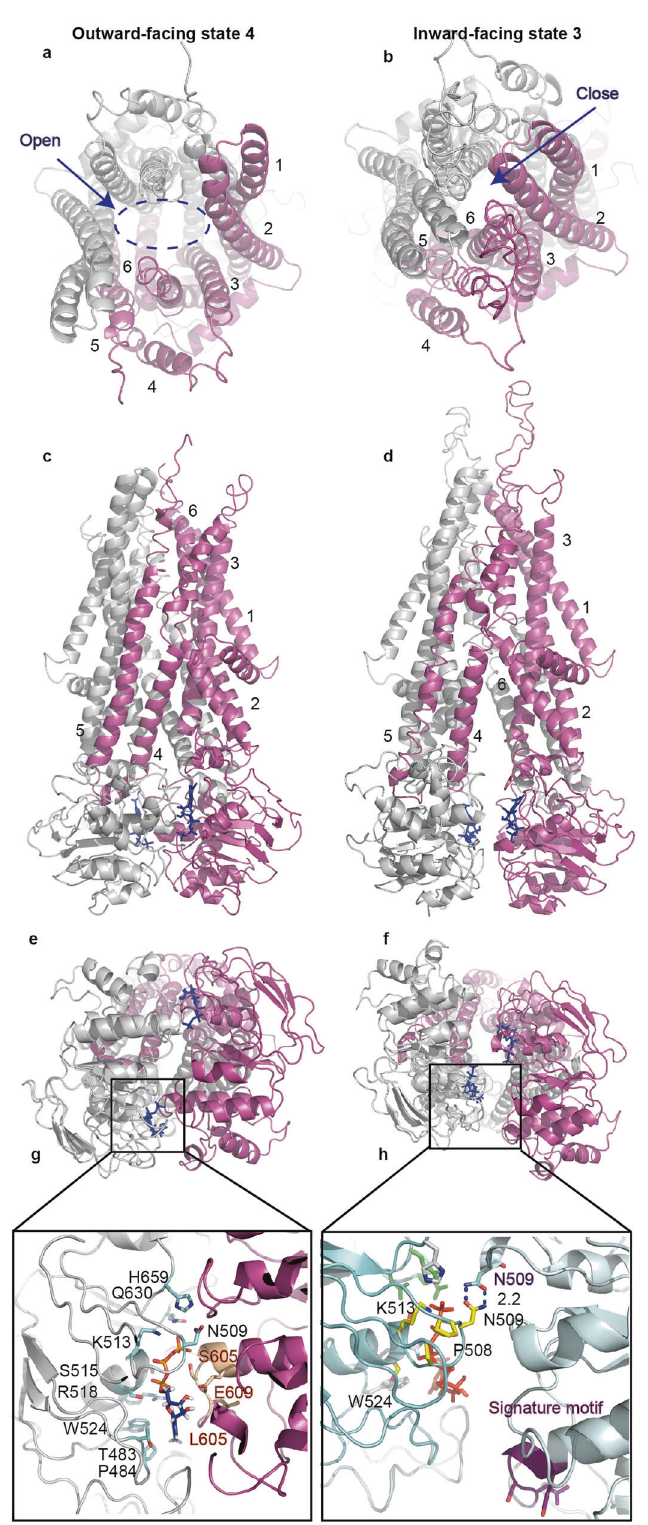
Fig. 4 ATP-bound inward-facing and outward-facing structures of ABCD1. a , c , e , d Cartoon structures representing ABCD1 in complex with ATP in outward-facing state. a , e View from the peroxisome lumen side and cytosol; c side view. g Zoomed-in view of the ATP-binding site. b , d , f , h Cartoon representations of ABCD1 in the complex of ATP in inward-facing state, viewed from a similar orientation as the outward- facing structure on the left